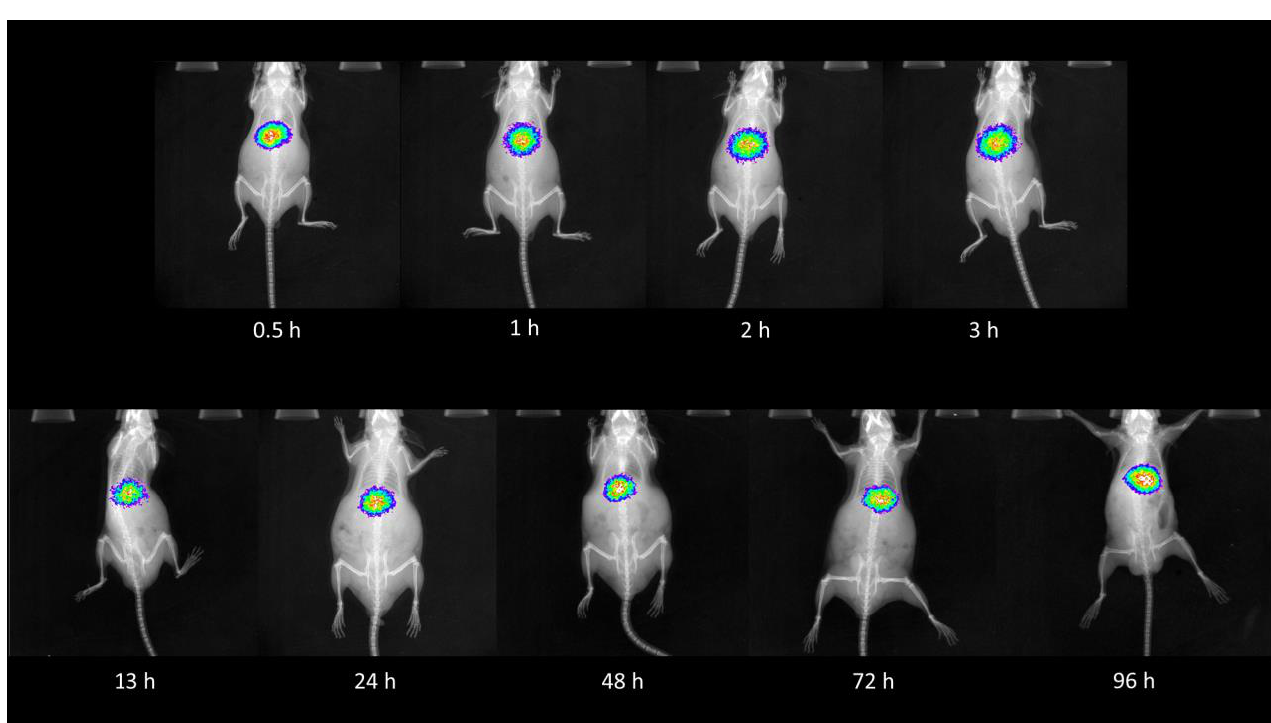
Figure 2. Radioluminescent images at various time points after the intravenous injection of 177 Lu 2 O 3 -iPSMA (13 MBq, 0.1 mg) in healthy CD1 mice. Table 3. Biodistribution (% injected dose) at various time points of 177 Lu 2 O 3 -iPSMA in nude mice bearing HCT116 tumors (mean ± SD) ( n = 3), after intratumoral injection. Tissue